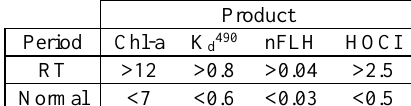
Table 2. The variation ranges of Chl-a, Kd490, nFLH, and HOCI in the RT and normal